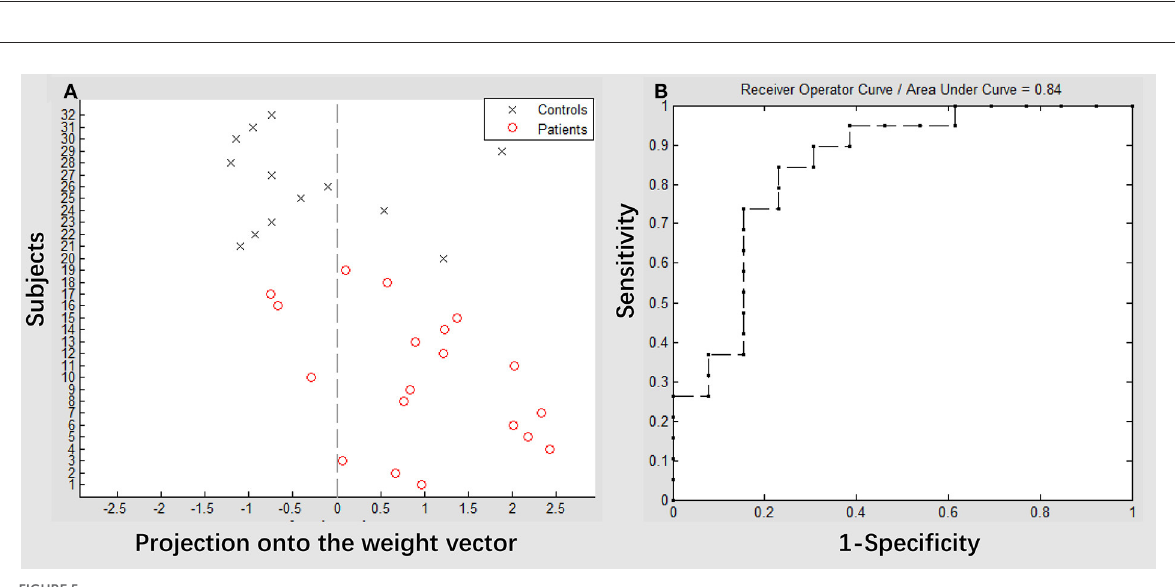
FIGURE5 Classification plot (A) and receiver operating characteristic (ROC) curve (B) for the comparison between groups. Voxel-mirrored homotopic connectivity maps of 19 patients with stroke (pretreatment) and 13 healthy controls were used for classification, which yielded an accuracy of 81.25% (84.21% sensitivity, 76.92% specificity), which was statistically significant at p <